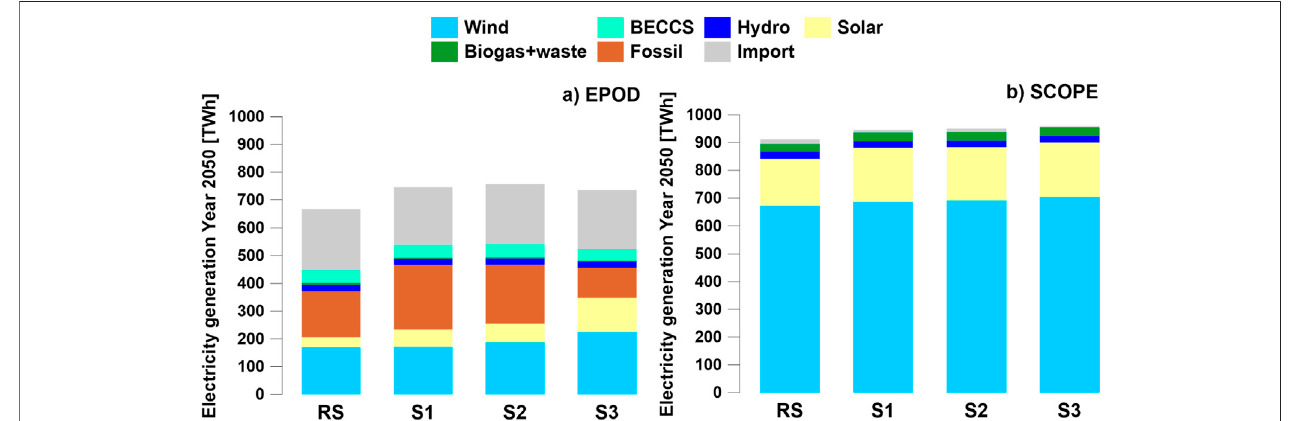
FIGURE 5 | Electricity generation in Germany in Year 2050 for all scenarios, as predicted by (A) EPOD and (B) SCOPE.